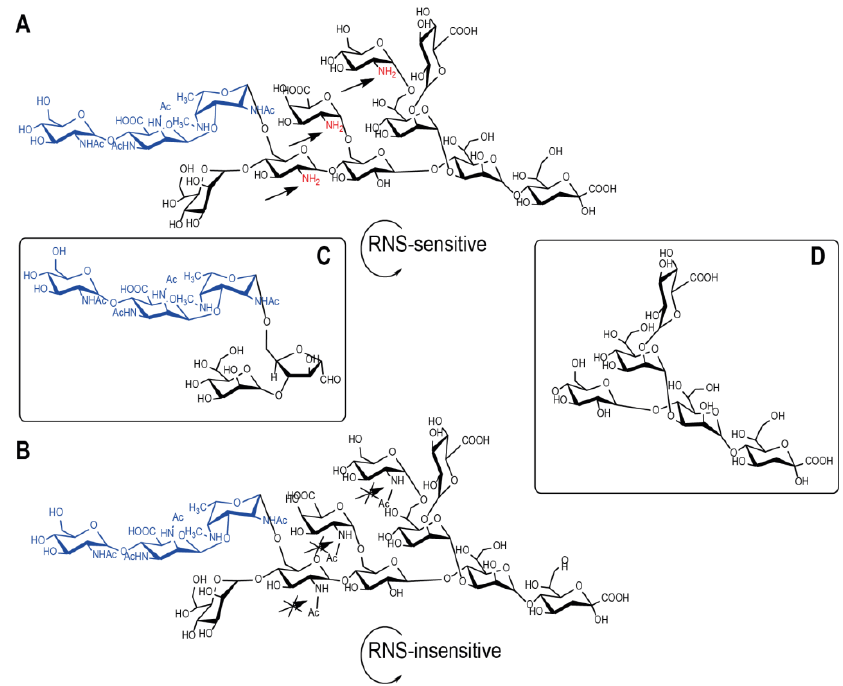
Figure 1. Structures of B. pertussis 186 LOS-derived oligosaccharides used as a model of the endosomal processing ( A ) complete native OS with free amino groups, making it vulnerable to RNS, ( B ) the N-acetylated OS form RNS-insensitive, ( C ) distal pentasaccharide, ( D ) the OS inner core segment, devoid of the pentasaccharide and the amine-bearing monosaccharides. The anticipated vulnera- ble structural elements and these subjected to modification by reactive nitrogen species (RNS) are indicated by colors in the structures. Arrows mark the RNS-sensitive/insensitive